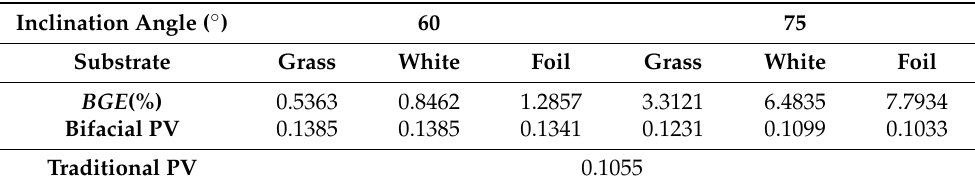
Table 20. Unit costs of electricity generation for various types of photovoltaic installations